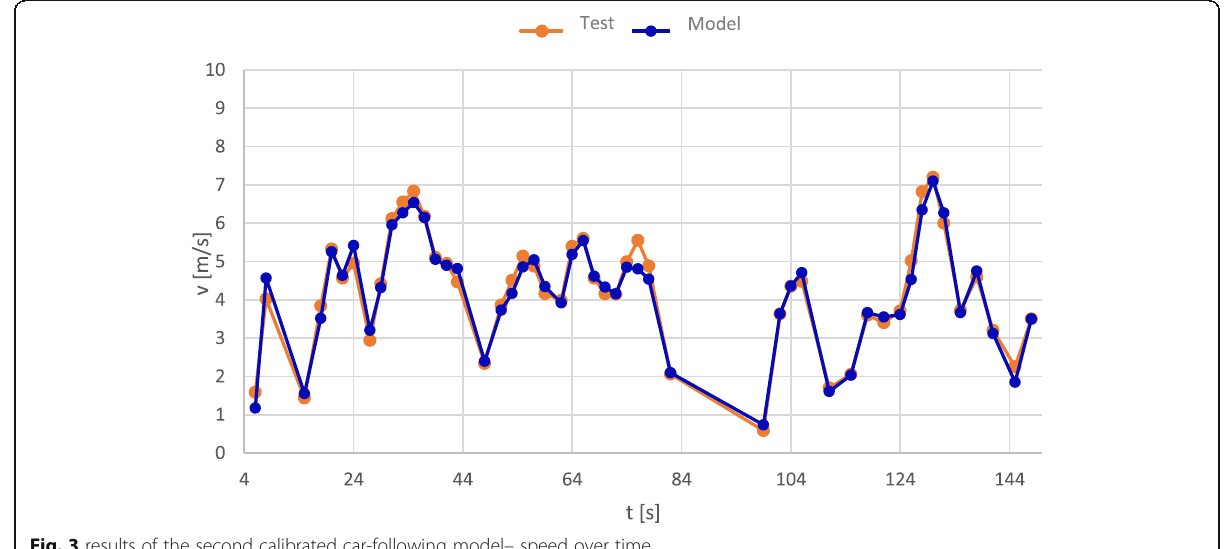
Fig. 3 results of the second calibrated car-following model – speed over